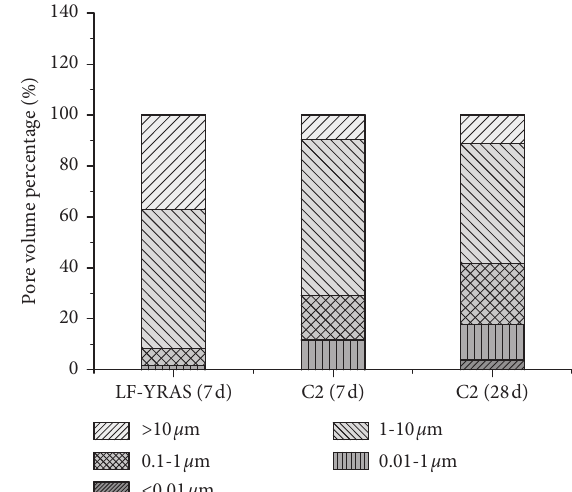
Figure 10: Pore classification and proportion of LF-YRAS (curing for 7d), C2 (curing for 7d), and C2 (curing for